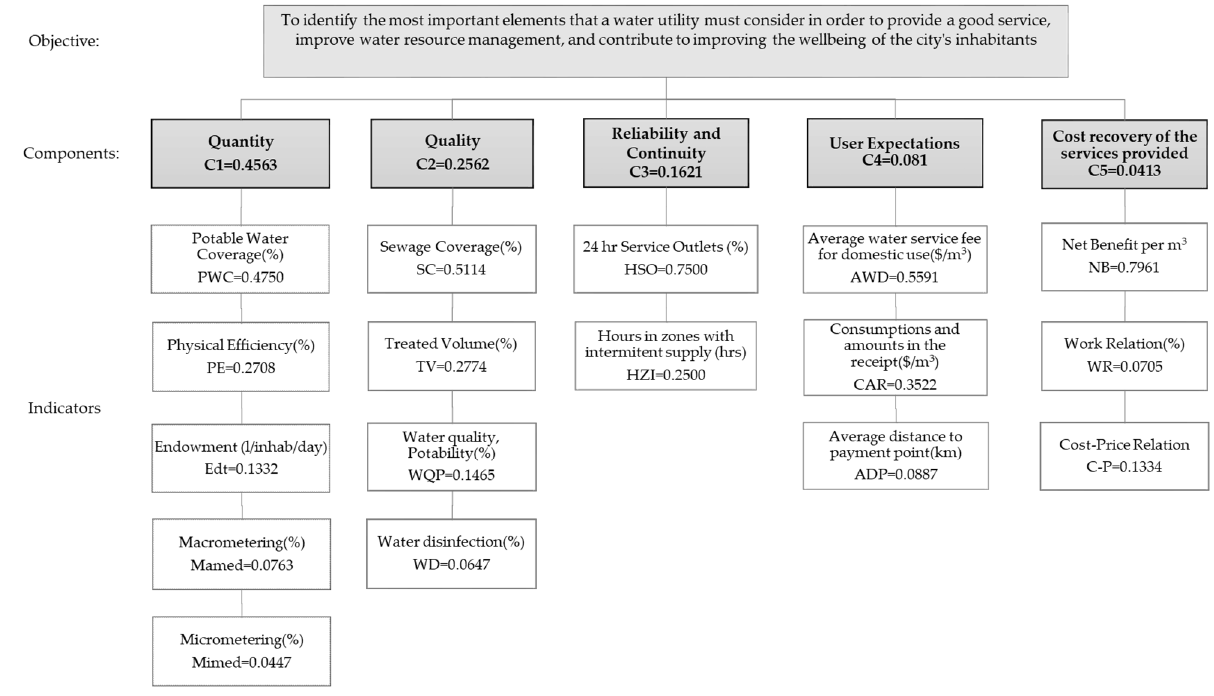
Figure 2. Hierarchical model to determine the elements that have an impact on water management.